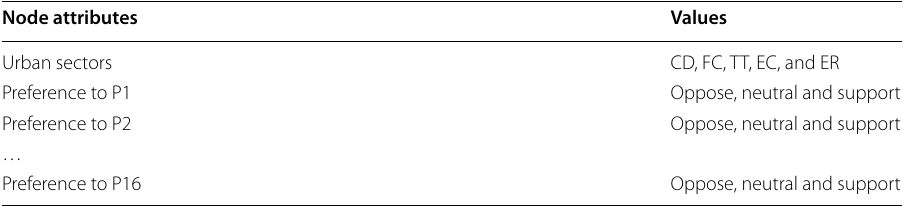
Table 3 Considered node attributes in the network Node